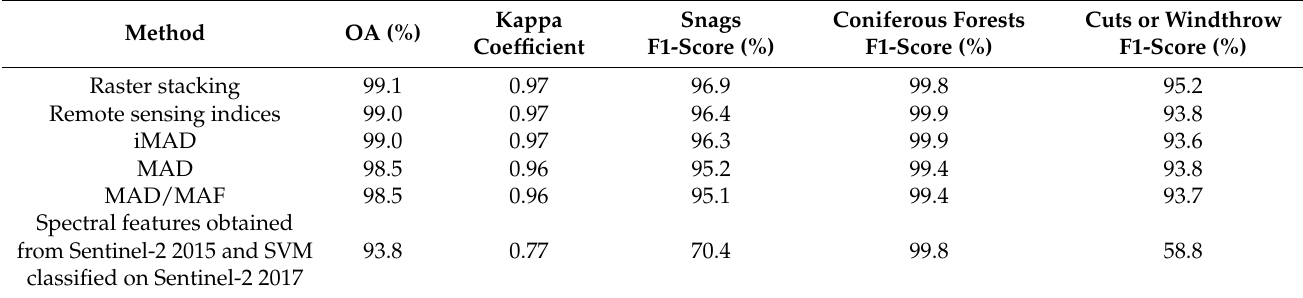
Table 6. Comparison of the accuracy of different methods of detecting changes between 2015 and 2017.